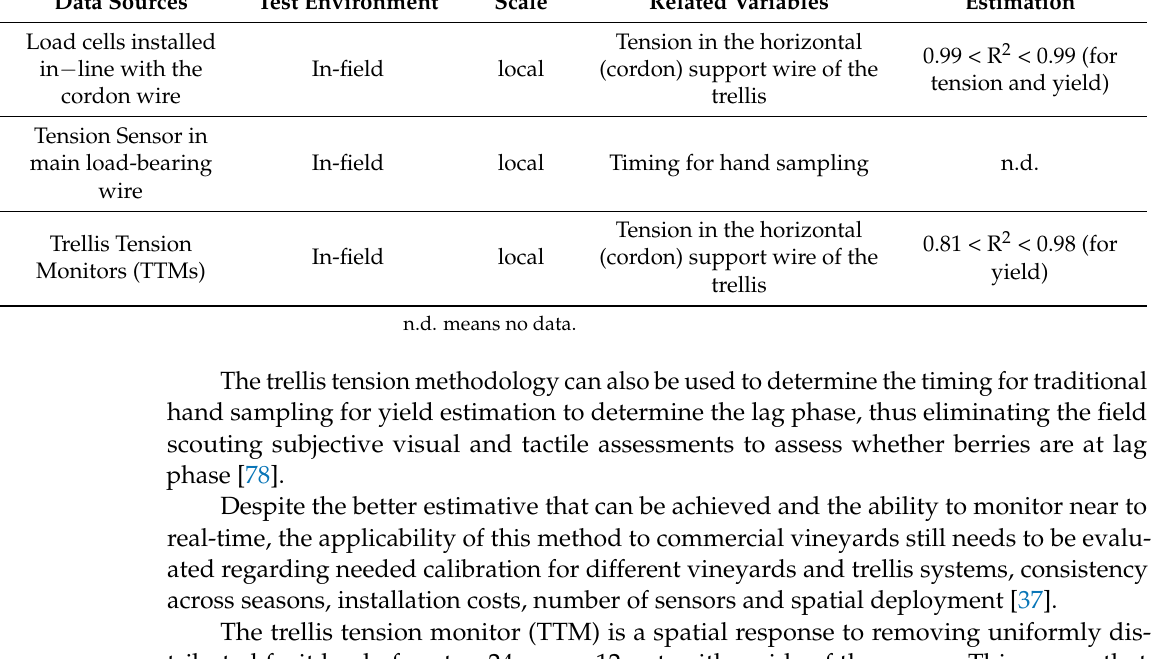
Table 6. Summary of records included in the systematic review (E—data-driven models based on trellis tension).